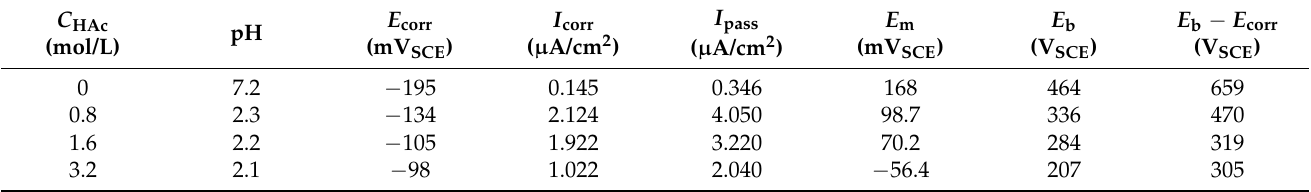
Table 1. Parameters from the polarization curves of 304 SS in 0.6 mol/L NaCl solutions with